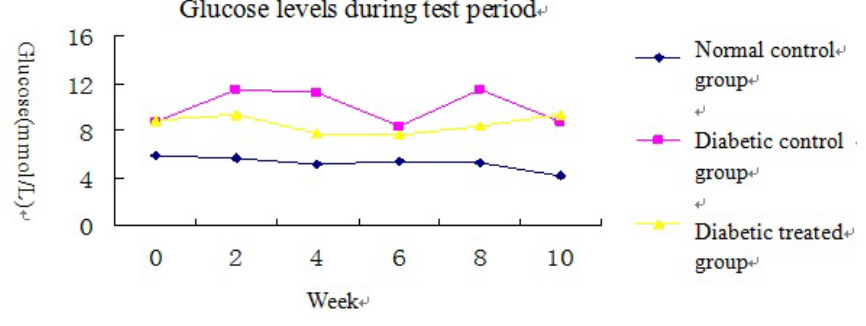
Figure 1. Glucose levels during test